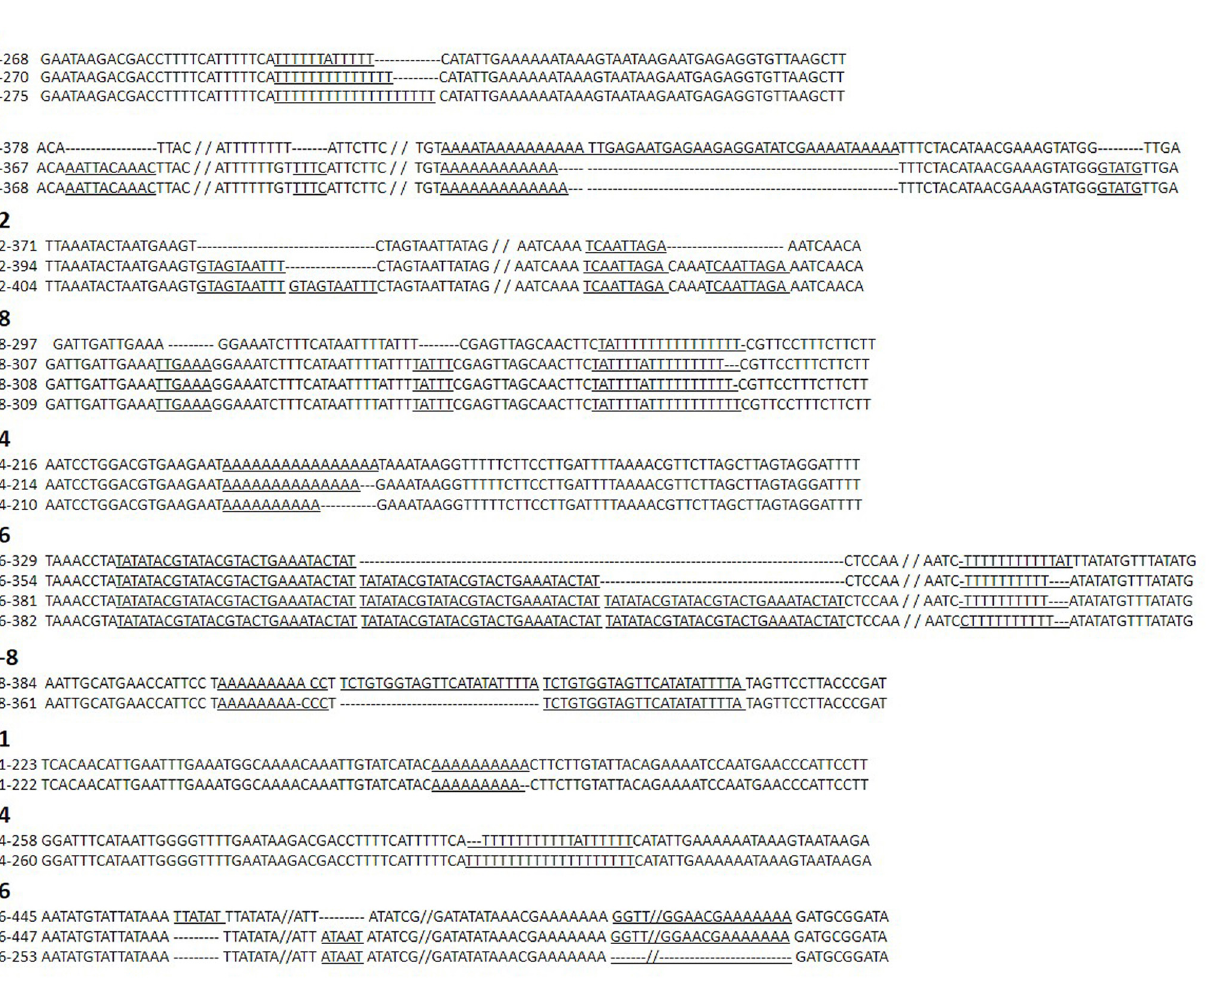
Fig 1. Sequence variation of the alleles detected in 10 cpSSRs.